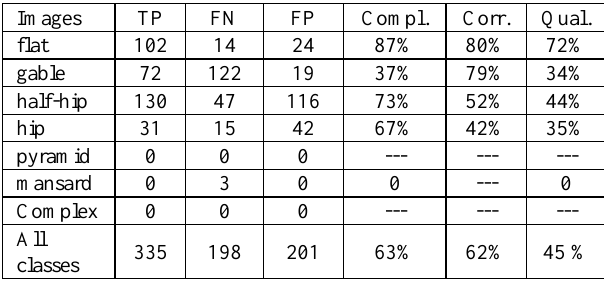
Table 3. Quantitative evaluation results for test data using the second